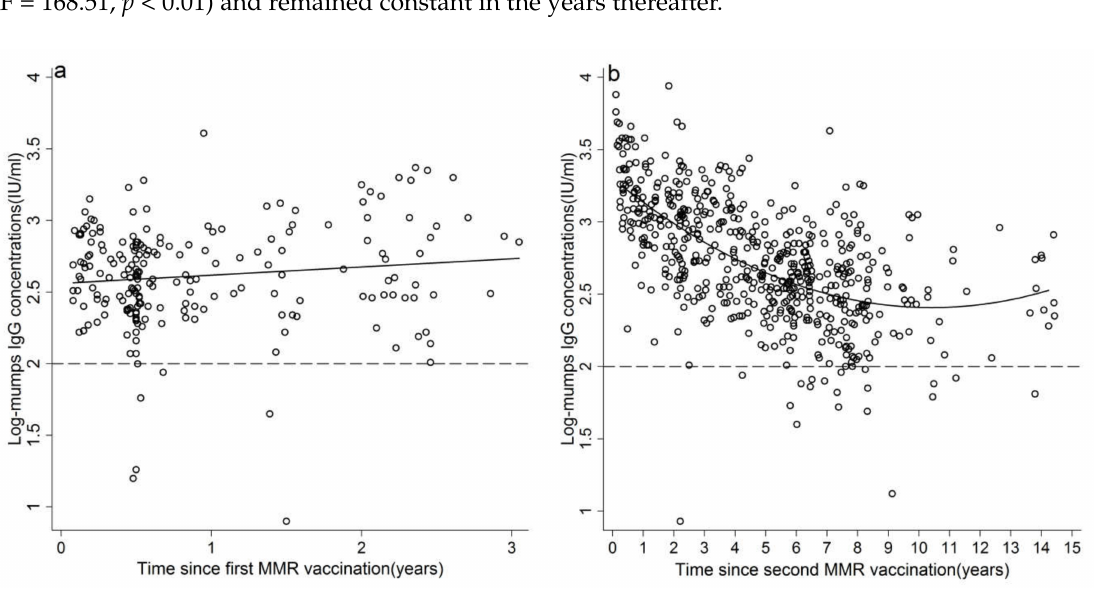
Figure 3. Mumps antibody persistence after first ( a ) and second ( b ) MMR vaccination. The fitted model (line) and cut-off for seropositivity (dash